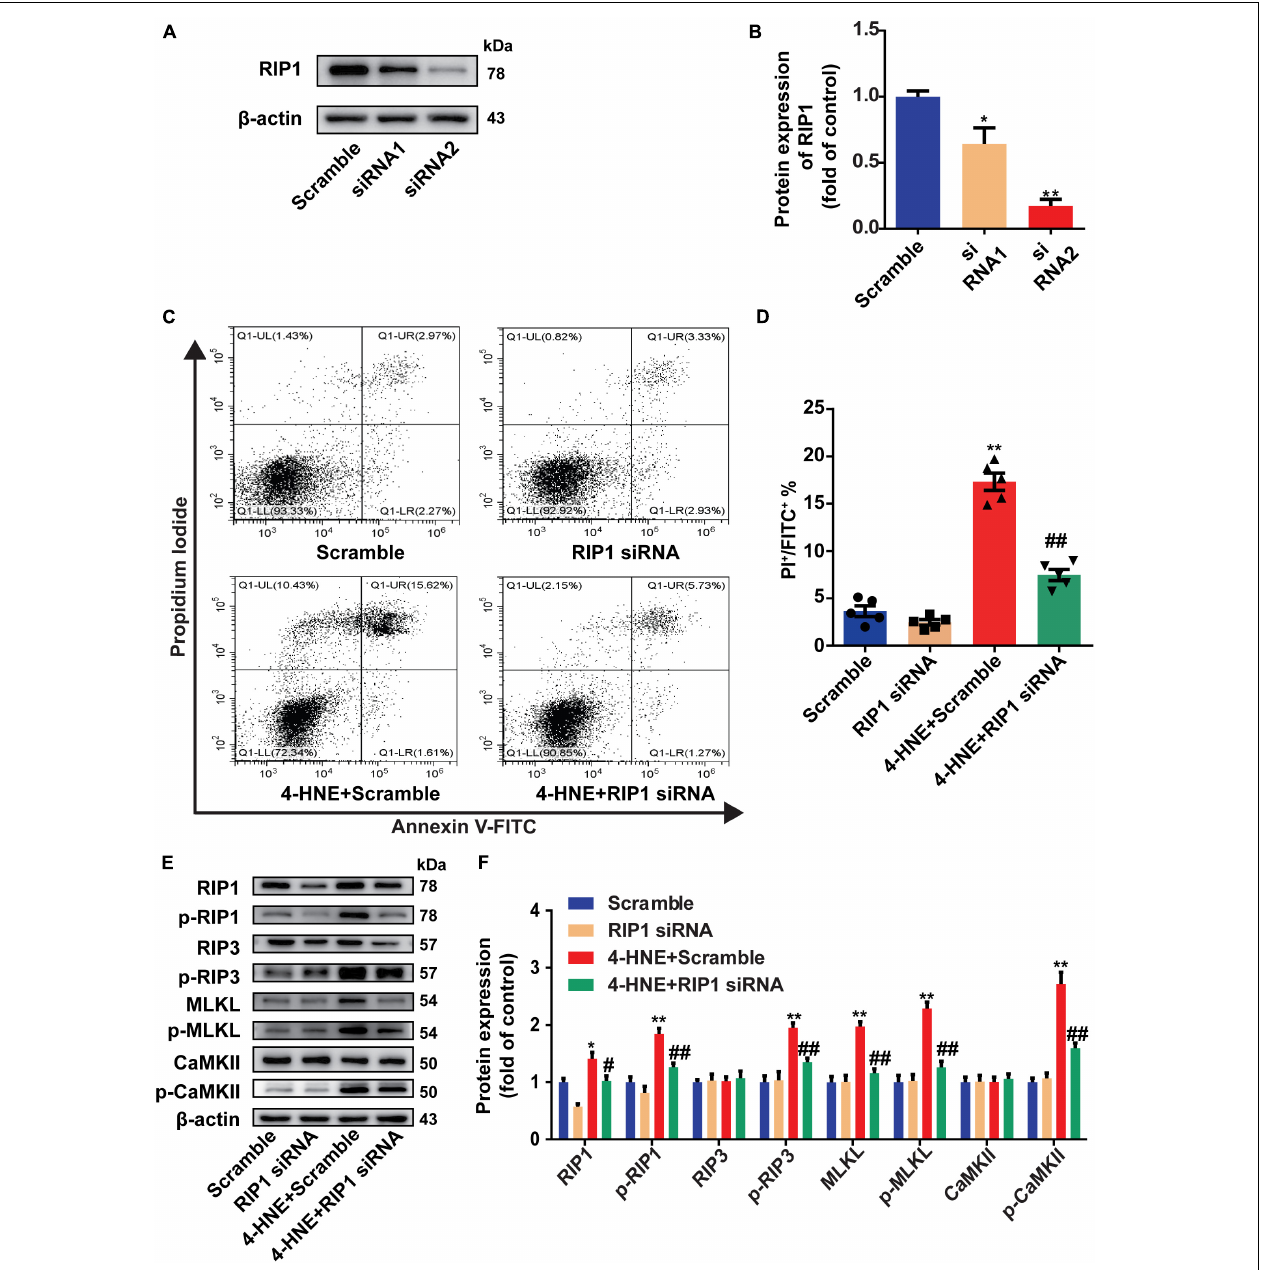
FIGURE 5 | Receptor-interacting serine/threonine-protein kinase 1 mediates the effect of 4-HNE on cardiomyocyte necroptosis. (A,B) Representative Western blots and relative expression of RIP1 in H9c2 cells treated with scrambled or RIP1-targeted siRNAs ( n = 3). (C,D) Necroptotic cells were analyzed by Annexin V/PI staining using flow cytometry ( n = 5). The necroptotic cells were indicated as Annexin V + /PI + cells. (E,F) Representative immunoblots and relative expression of RIP1, p-RIP1, RIP3, p-RIP3, MLKL, p-MLKL, Ca 2 + /CaMKII, and p-CaMKII in different groups treated with scramble or RIP1 siRNA with or without 4-HNE stimulation in H9c2 cells ( n = 5). * p < 0.05 vs. scramble group, ** p < 0.01 vs. scramble group; # p < 0.05 vs. 4-HNE + scramble group, ## p < 0.01 vs. 4-HNE + scramble